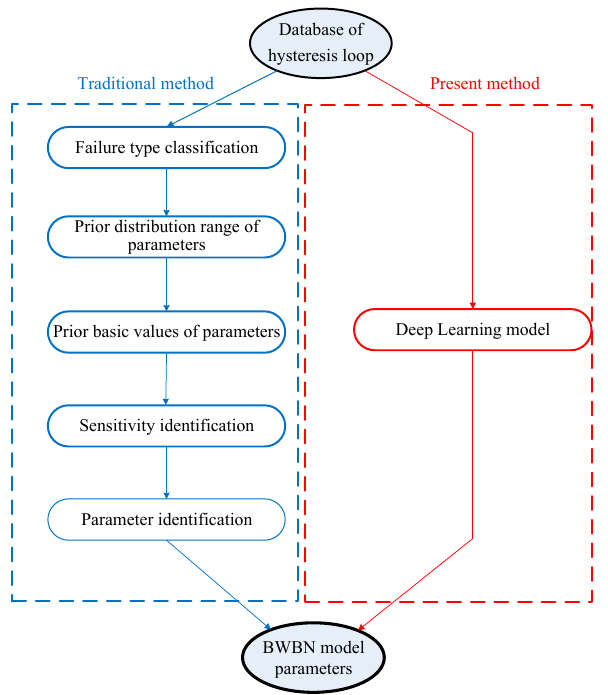
Figure 3. Comparison of traditional and present identification method.